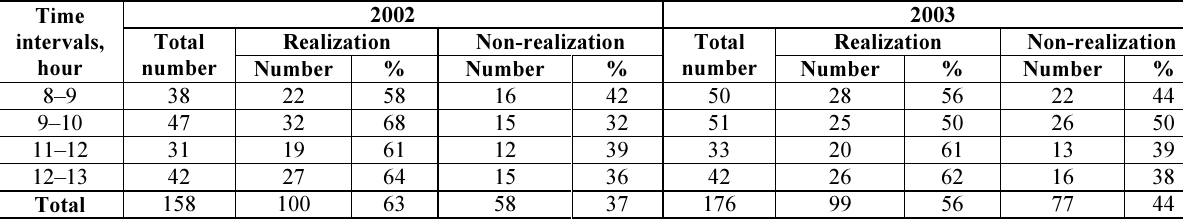
Table 4. Efficiency of prognostic connection of HCRF decrease between two adjacent days at an interval 1.2–1.6 MeV (criterion –25 imp/h) and atmospheric pressure (criterion 4 hPa) at various time intervals in Vilnius in